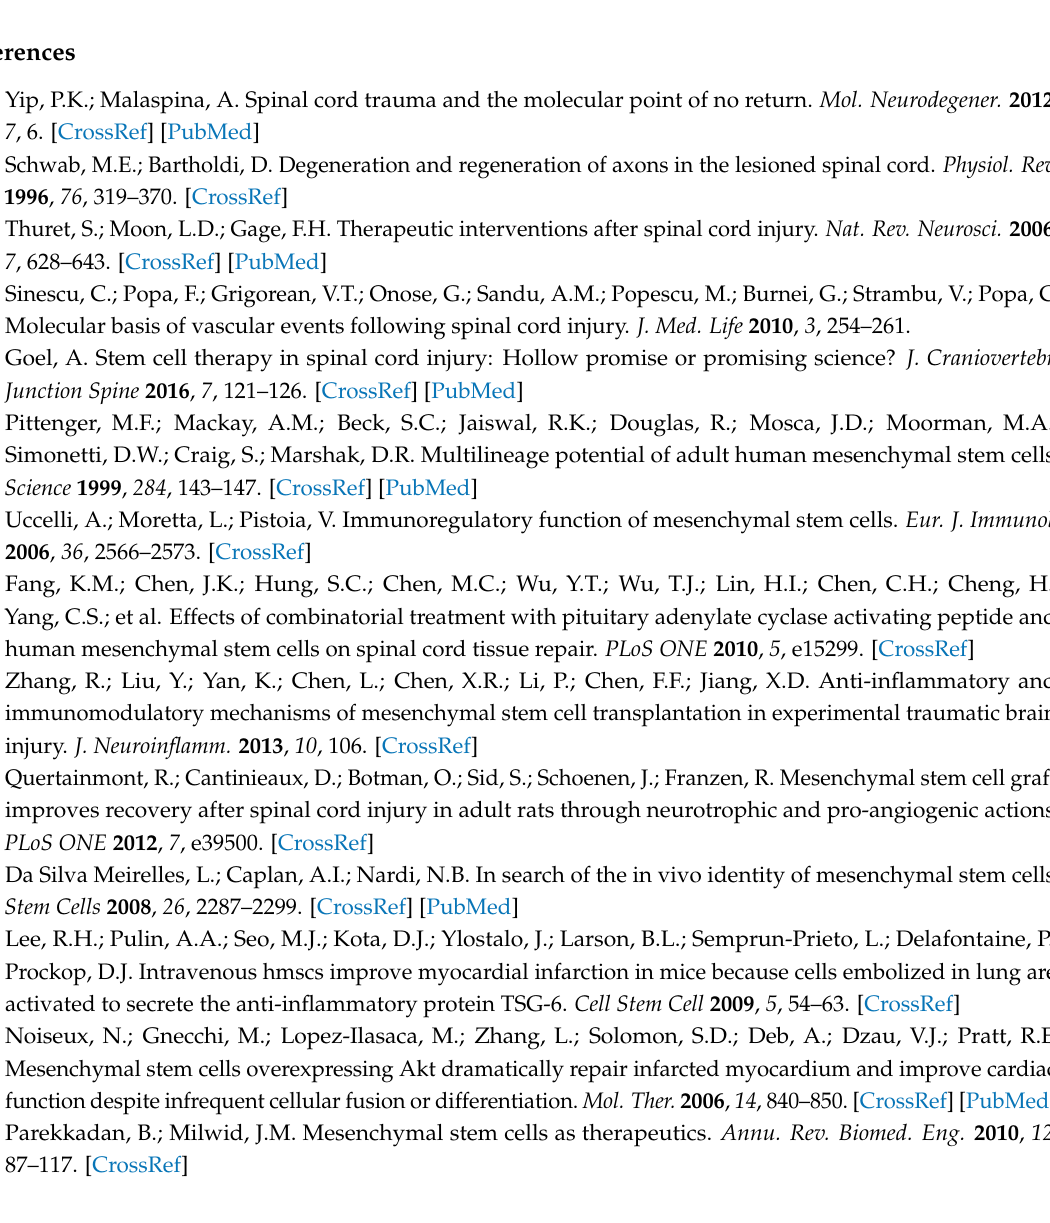
Figure S1: Characterization of rat bone marrow mesenchymal stem cells (BM-MSC), Figure S2: Factors revealed in conditioned medium of BM-MSC, Figure S3: Expression of protein levels in normal or injured spinal cord of rats at 7 days